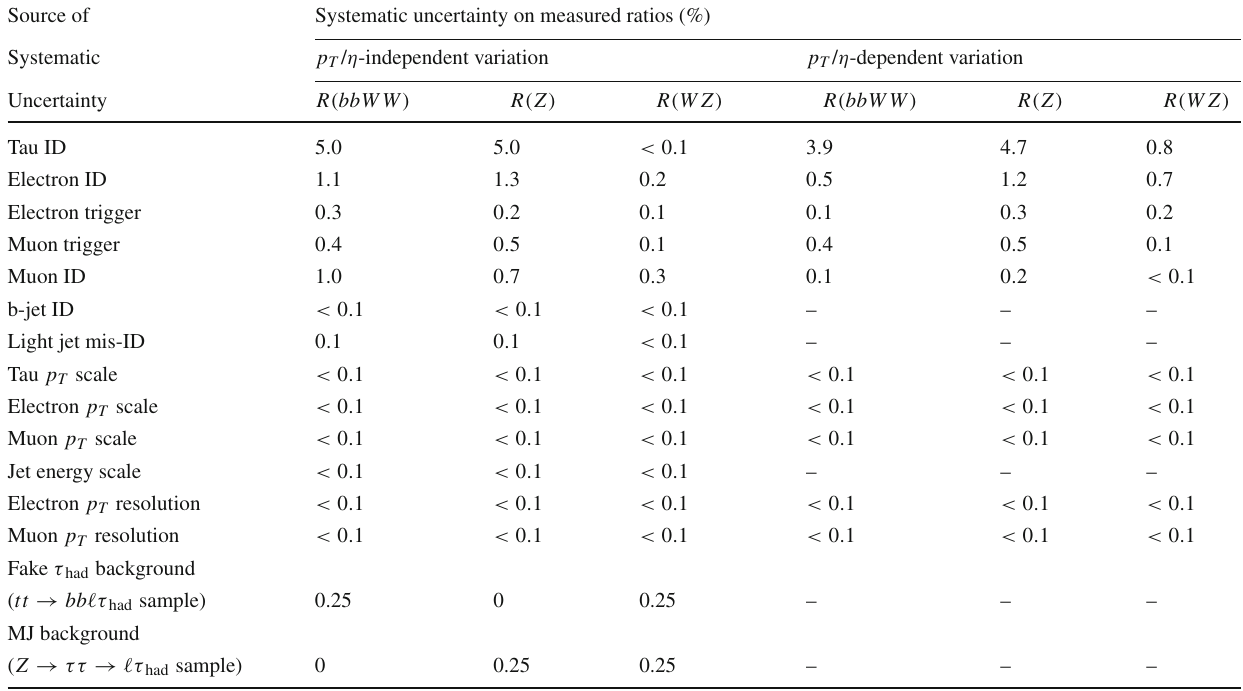
Table 4 Changes in the ratios R ( bbWW ) , R ( Z ) , and R ( W Z ) resulting from the sources of experimental systematic uncertainty described in Sect. 2.1 and summarised in Table 1. The p T / η -independent and p T / η -dependent systematic variations are considered